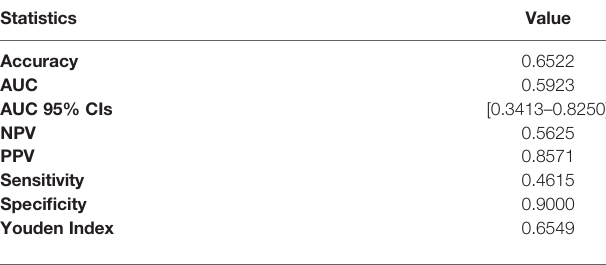
TABLE 9 | ROC analysis of ADC radiomics parameters.